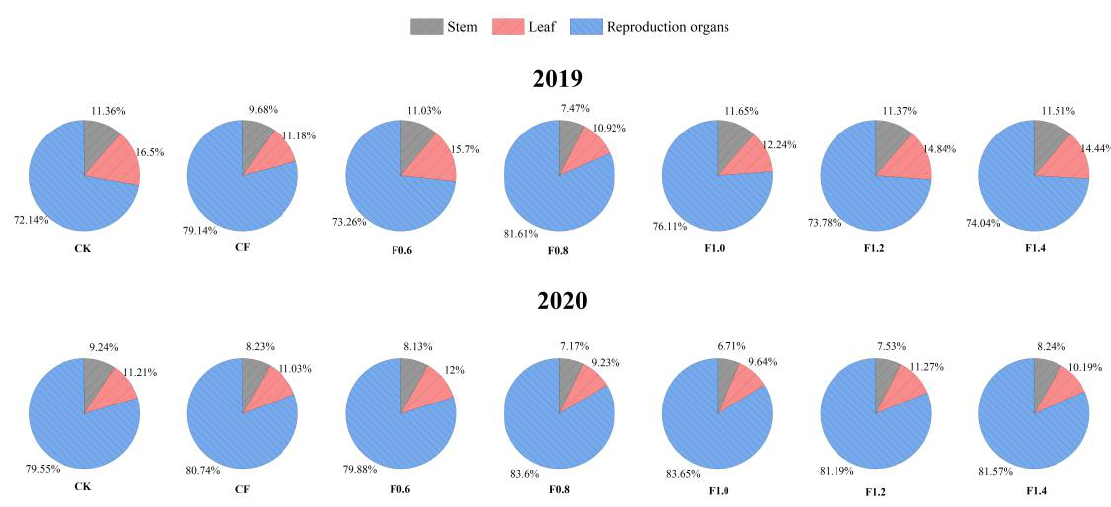
Figure 5. Distribution of P in different organs under different fertilization patterns during harvest.